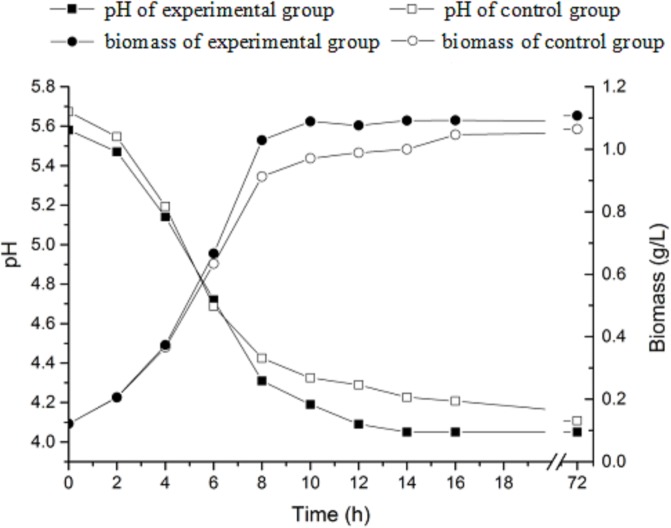
Comparison of pH and biomass in CDM culture with or without L-MSG.The solid square and circle show the pH and biomass of the experimental group. The hollow square and circle show the pH and biomass of the control group.